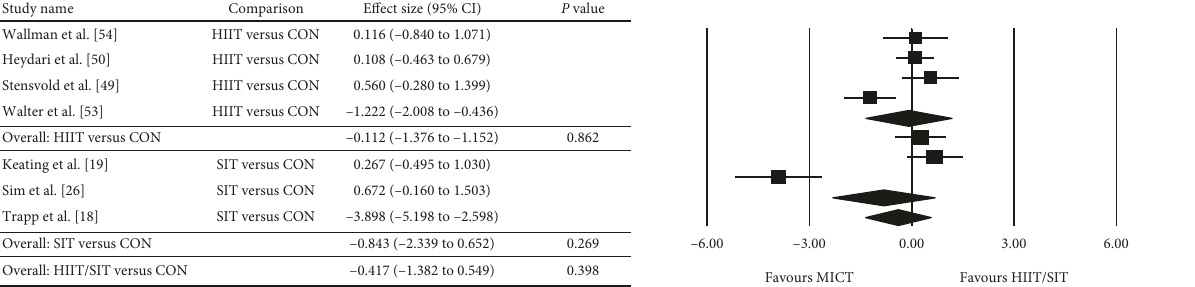
Figure 3: Effect of HIIT/SIT versus CON on energy intake. HIIT: high-intensity interval training, SIT: sprint interval training, CON: control, and CI: confidence